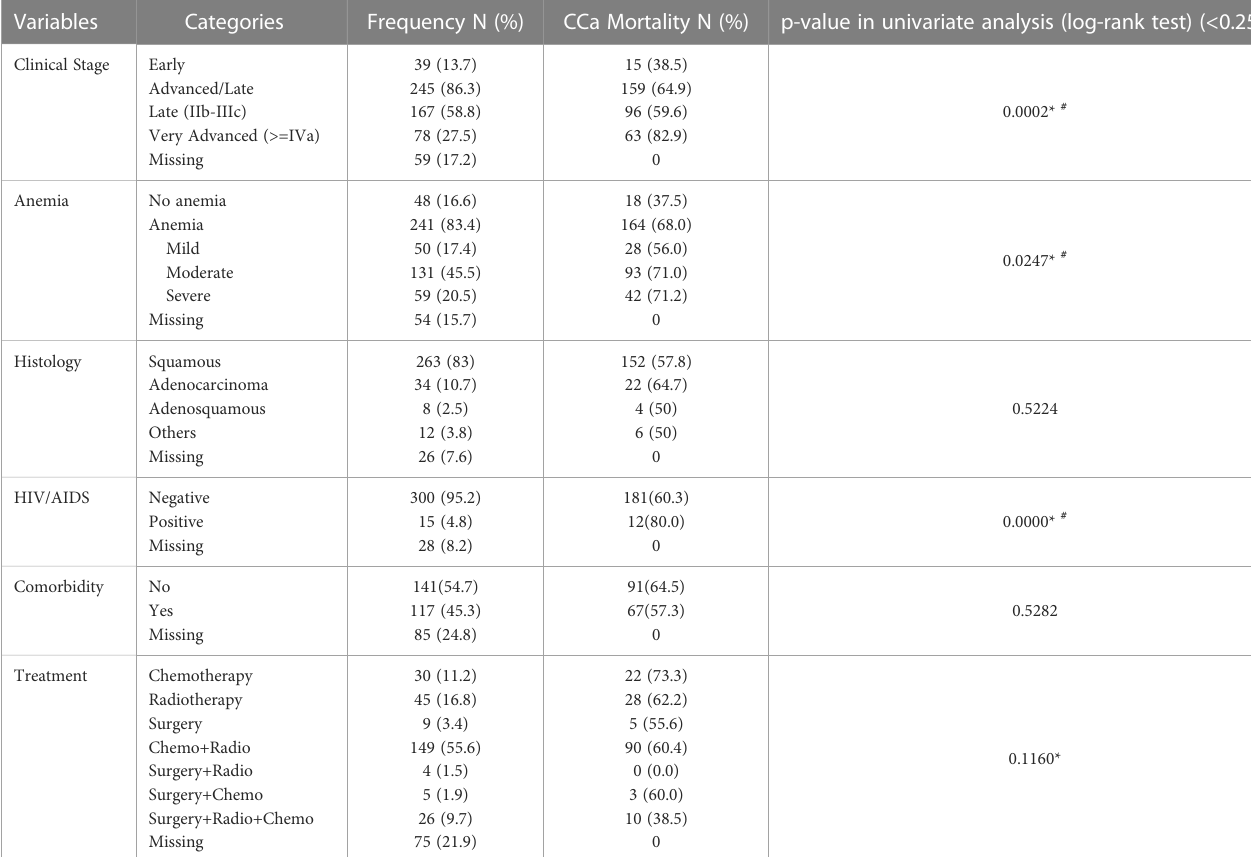
TABLE 2 Clinical characteristics of the study population, mortality pattern within each group, and results of univariate analysis.